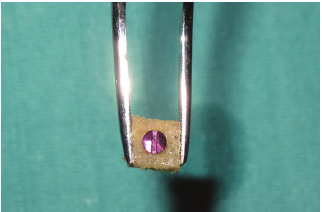
Figure 2: Prepared bone block predrill and adapted Titanium